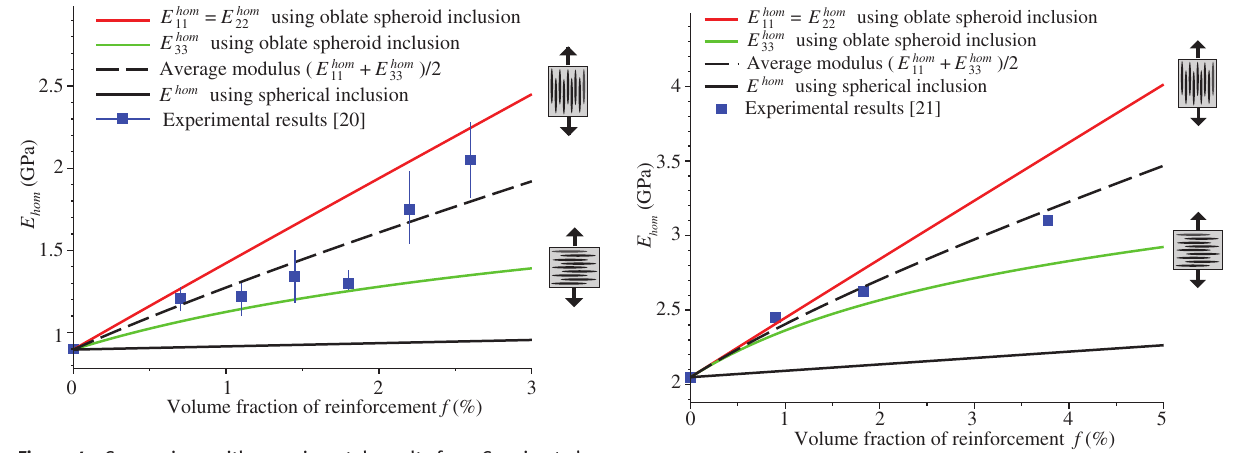
Figure 4 Comparison with experimental results from Cauvin et al.